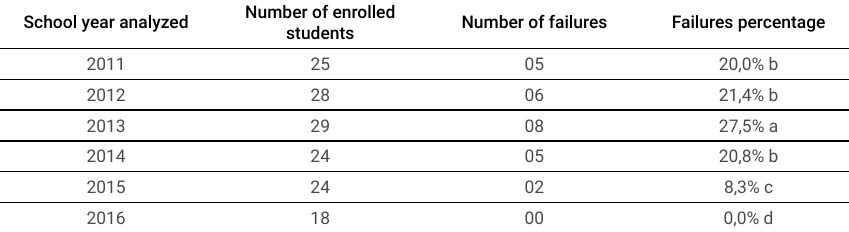
Table 2. Percentages of failures o nigh-time course students in the Pharmacology subject at FOA/UNESP, according to the school year analyzed Number of enrolled School year analyzed Number of students